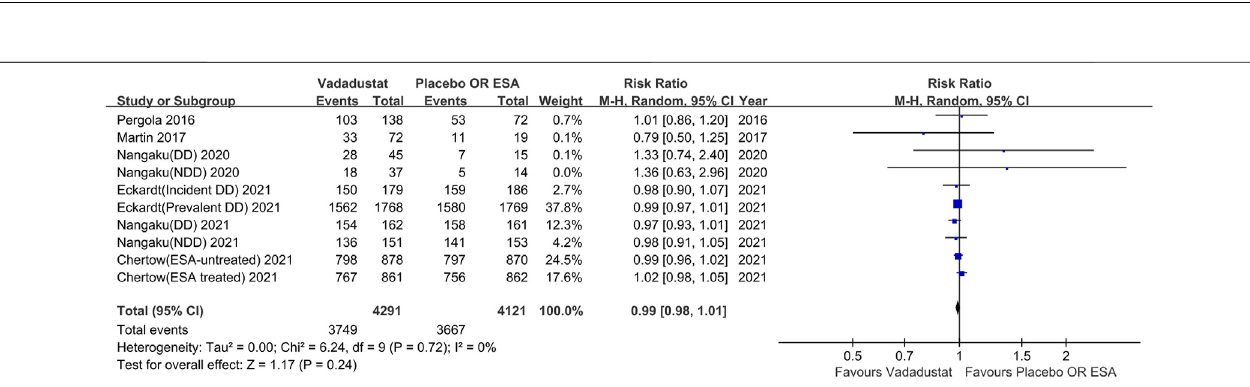
FIGURE 3 | Change in Hb level from baseline for vadadustat versus placebo and darbepoetin alfa. Hb, hemoglobin; ESA, erythropoiesis-stimulating agent, only darbepoetinalfa.Theregistrationnumber ofNangaku (NDD)2020corresponds toNCT03054337;Nangaku (DD)2020correspondstoNCT03054350,Nangaku(NDD) 2021 corresponds to NCT03329196, Nangaku (DD) 2021 corresponds to NCT03439137.